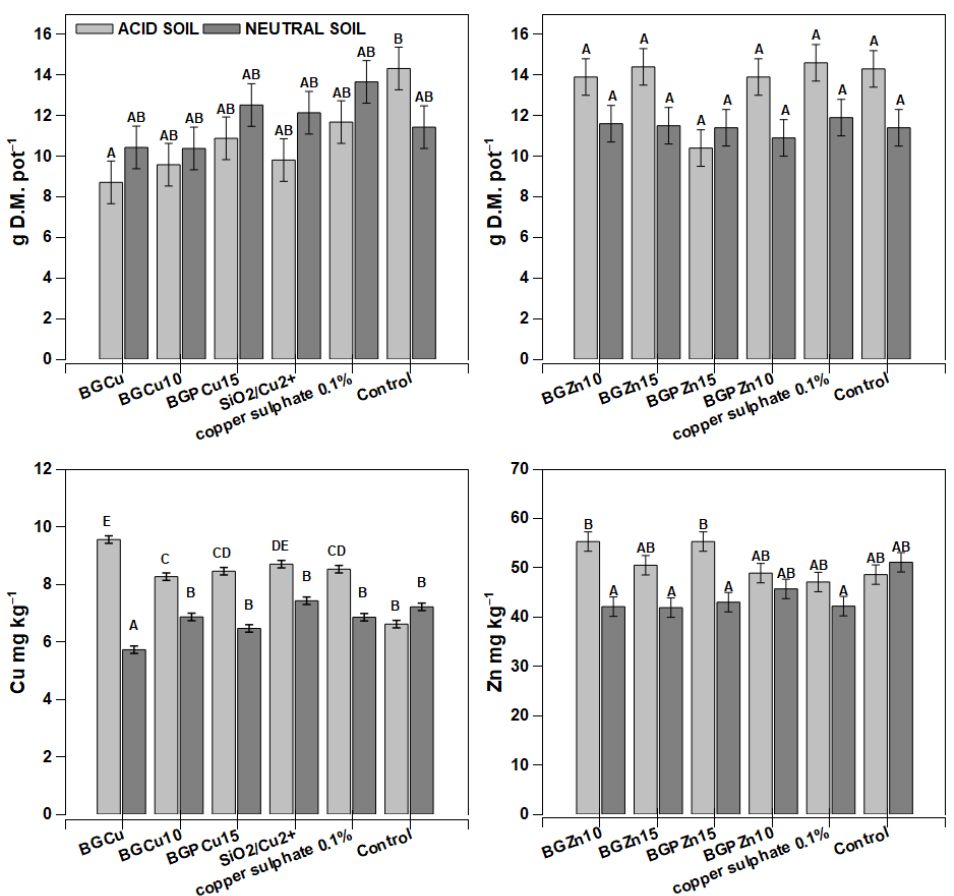
Figure 5. Yields of wheat (Triticum sativum) and concentration of copper and zinc after foliar applica- tion of different fertilizer formulations. Grey bars for acid, dark grey for neutral soil. Bars marked with the same letters represent homogenous groups after Tukey’s test at p < 0.05 and error bars represent standard error (n =